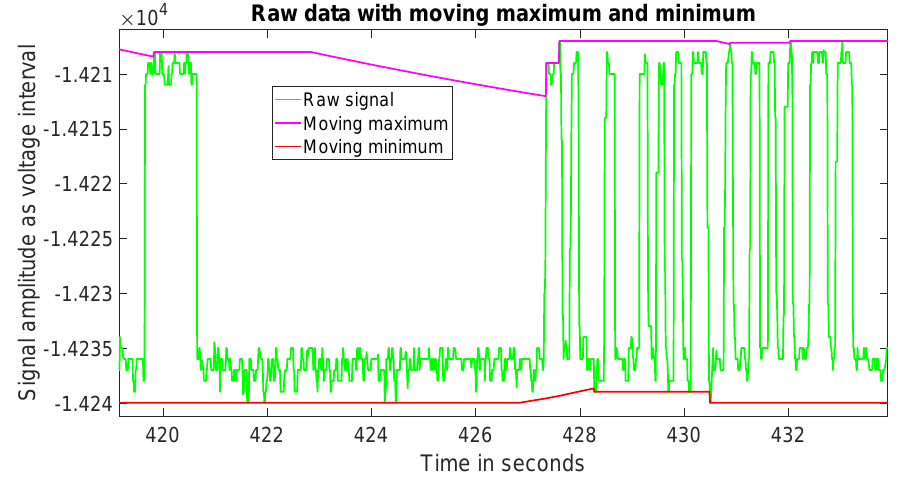
Figure 10. Sample of data packet featuring the moving maximum and minimum